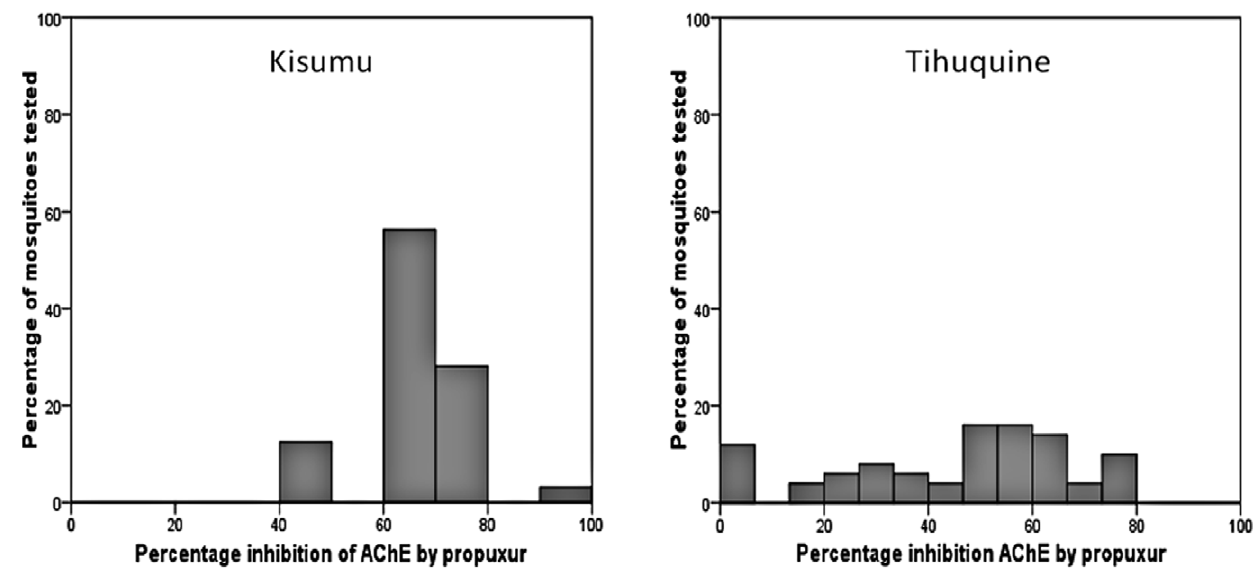
Figure 2. Acetylcholinesterase inhibition rate by propuxur. Acetylcholinesterase inhibition ranges in the An. funestus from Tihuquine compared to the An. gambiae insecticide-susceptible Kisumu reference strain.